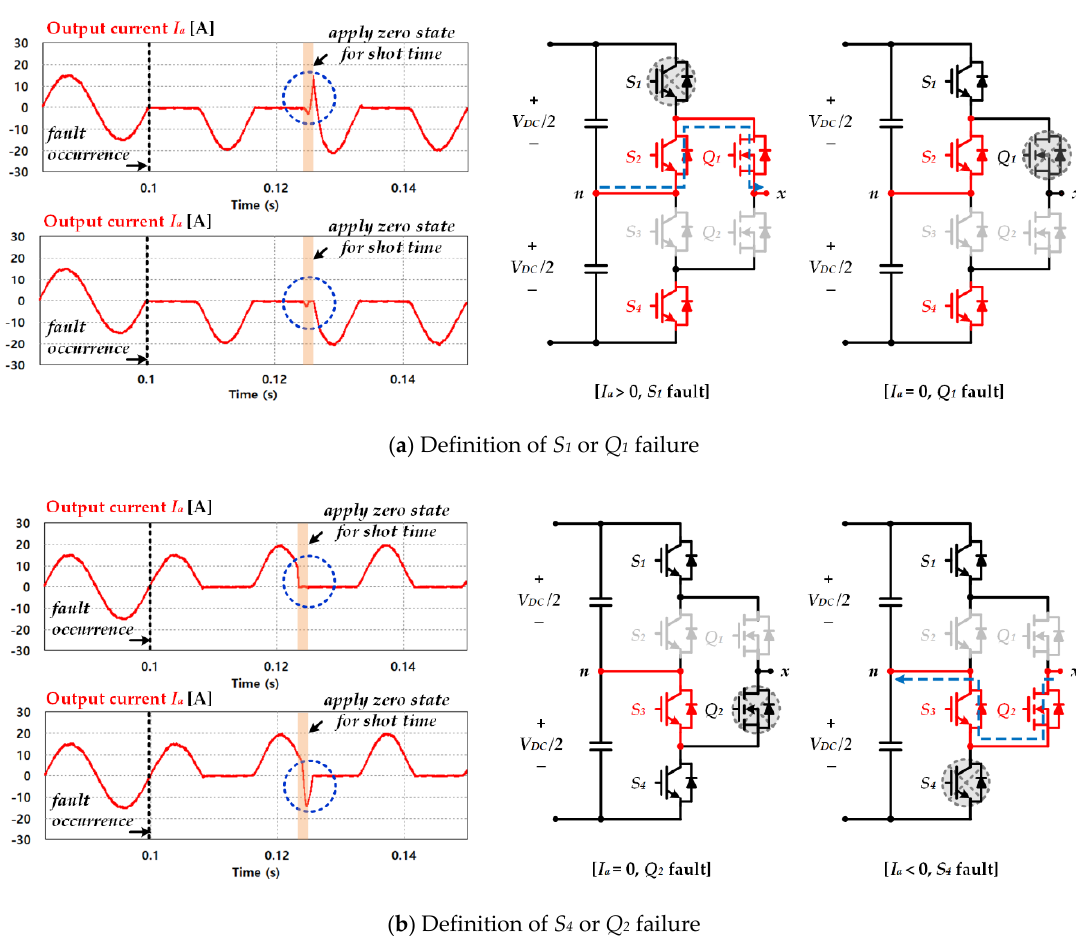
Figure 9. Distinguishing process of faulty switch in Si-IGBT or SiC-MOSFET by injecting zero-switching